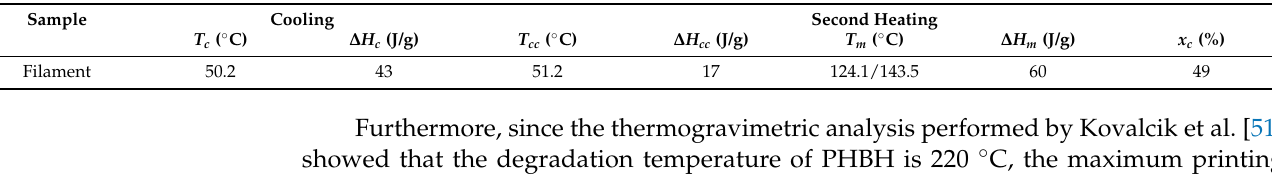
Figure 2. DSC scans of cooling and second heating for the filament of PHBH. Table 4. Thermal DSC cooling and heating properties of the PHBH